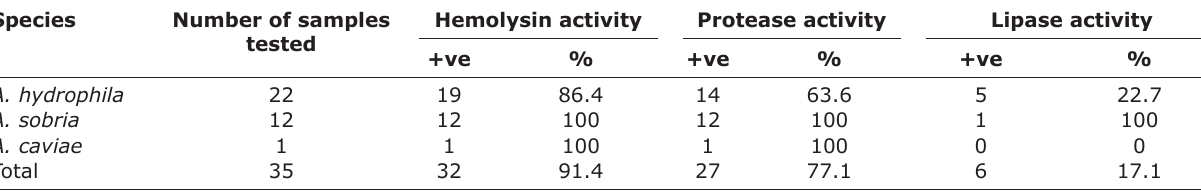
Table-4: Prevalence of virulence factors tested from Aeromonas spp.